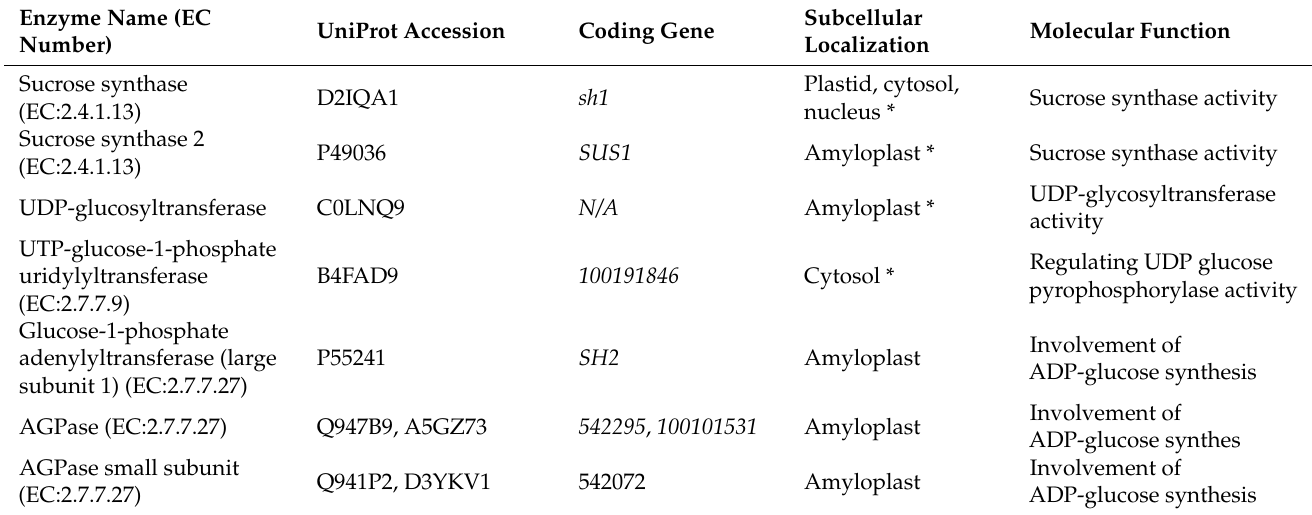
Figure 3. Starch biosynthesis in maize endosperm. Black arrows show the conventional biosynthesis of starch: glucose-1-P is converted to ADPG, which is transported into the amyloplast and polymer- ized into starch. Red arrows show the oxidative pentose phosphate pathway, which provides NADPH and pentose sugars for starch synthesis. 1, sucrose synthase; 2, UDP-glucose pyrophosphorylase; 3, hexokinase; 4, AGPase; 5, phosphoglucomutase; 6, complexes including AGPase, starch synthase IIa (SSIIa), SSIII, starch branching enzyme IIb (SBEIIb), and SBEIIa; 7, glucose-6-phosphate dehydrogenase; 8, 6-phosphogluconate dehydrogenase; 9, malic enzyme; 10, transaldolase; 11, transketolase; 12, triose-P/P translocator and P/phosphoenolpyruvate translocator. Table 3. Key enzymes identified by proteomic analyses of starch biosynthesis during maize seed development.